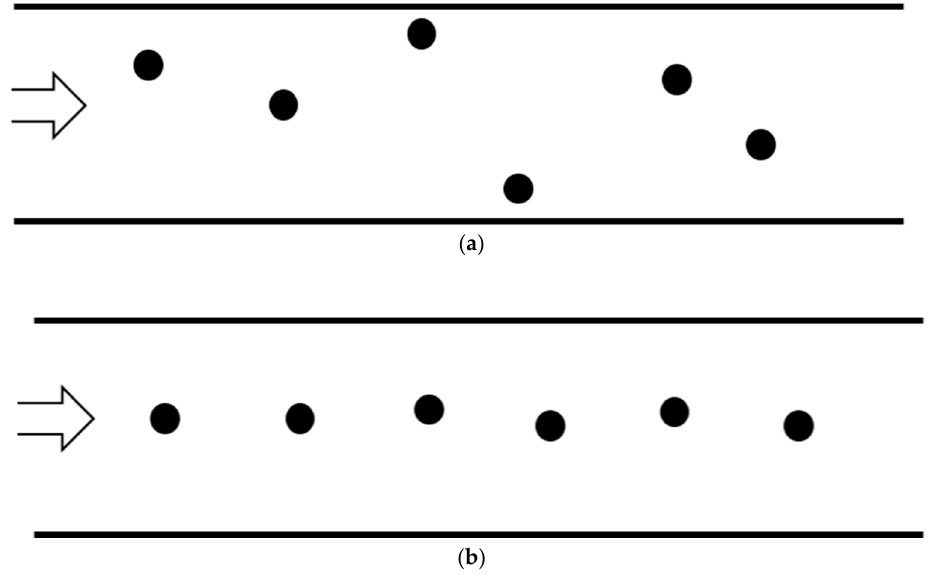
Figure 13. ( a ) Random dispersed particle. ( b ) Focused on center of channel due to the interaction between particle and wall.